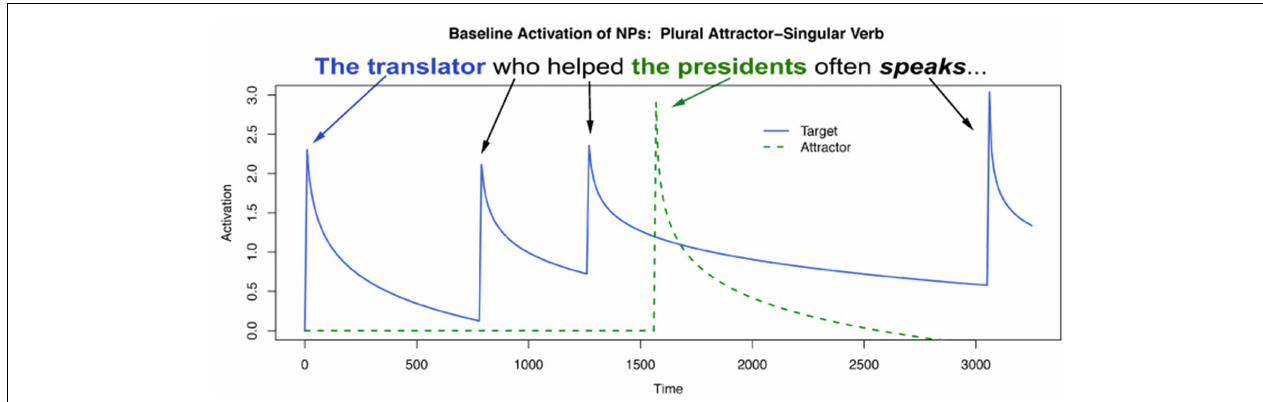
FIGURE 6 | Model activation values over time for an ACT-R model of grammatical attraction conditions.